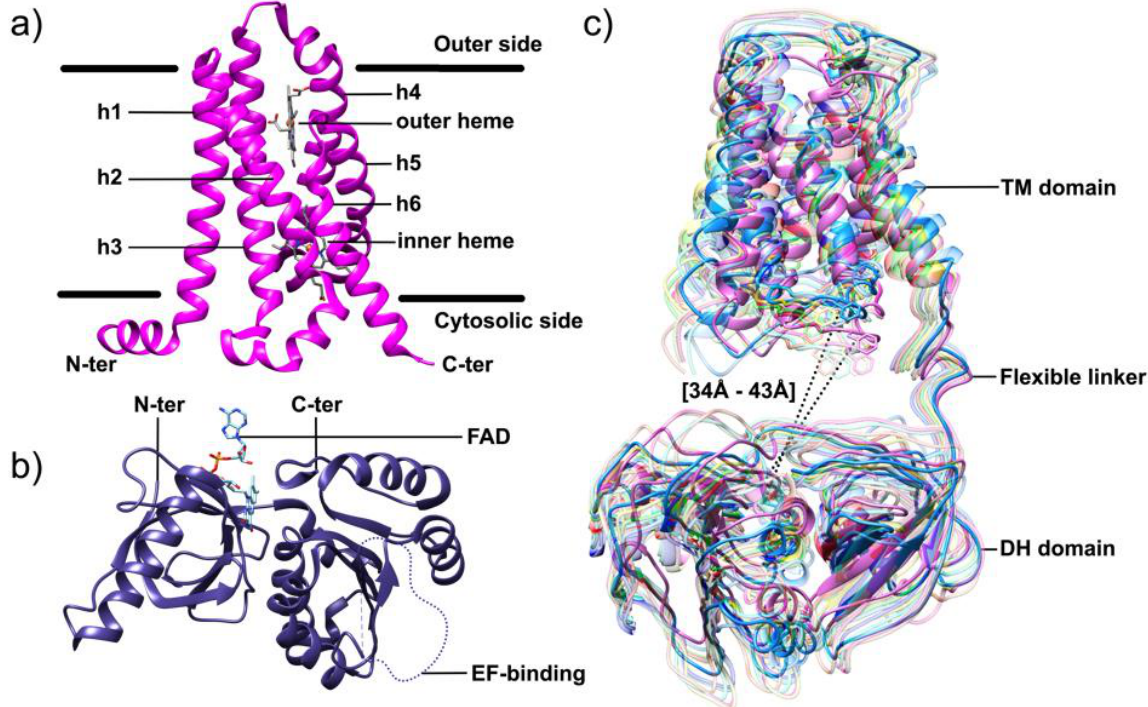
Figure 12. Structure of the DH and TM domains of CsNOX and the SANS structure of SpNOX. ( a ) TM domain of CsNox solved by X-ray crystallography at 2.05Å resolution [64]. The 6 transmembrane helices and the two chelated hemes are labelled. The positions of the bilipidic layer are indicated by the horizontal black lines. ( b ) The DH domain of CsNox was solved by X-ray crystallography at 2.2Å resolution. The FAD cofactor co-crystallized with the protein is la-belled and the unstructured EF-hand-binding loop is depicted in dotted gray (D611-T634). ( c ) Some of the conformations generated by Pepsi-SANS along Non-linear Normal Mode Analysis for SpNOX in a semi-transparent ribbon style [226]. The two most distant conformations have been represented in opaque ribbon; between these two configurations, the gap between the D-loop of the TM domain and the FAD-binding site varies from 34 to 43 A, highlighting the flexibility of the inter-domain